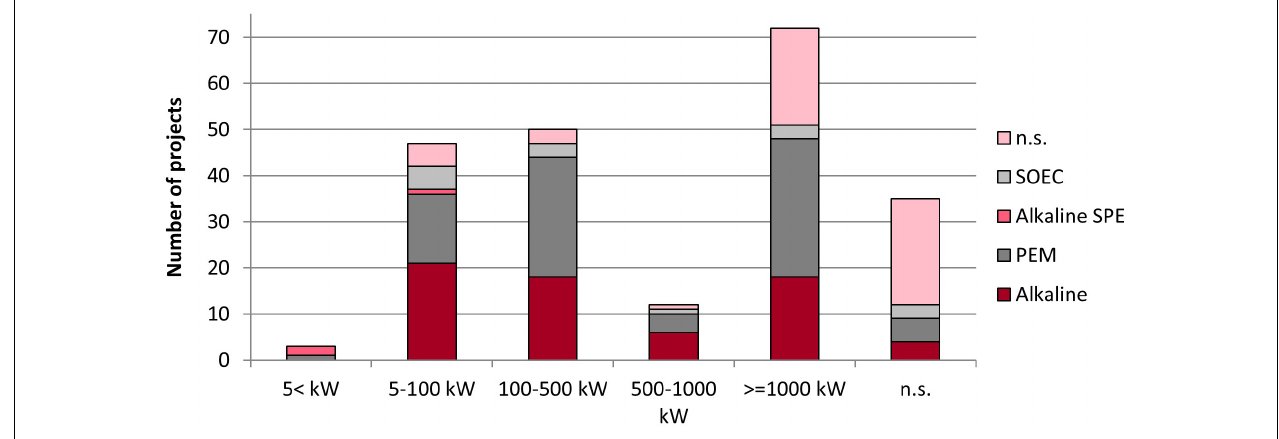
FIGURE 7 | Electrolyzer types according to capacity. PEM, Polymer electrolyte membrane; SOEC, solid oxide electrolyzer cell; SPE, solid polymeric